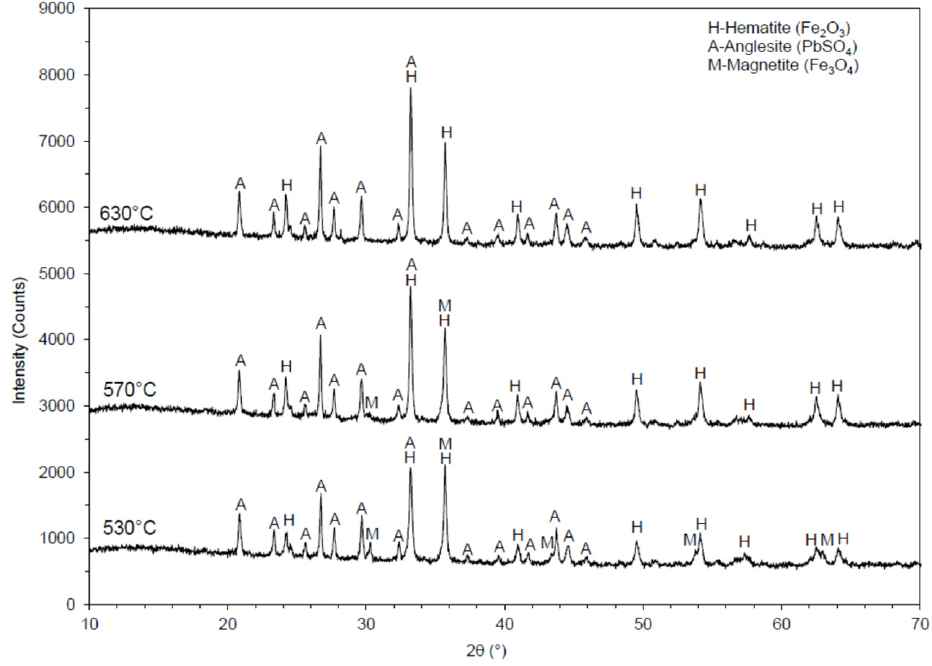
Figure 7. Diffractogram of calcined jarosite samples at 530, 570, and 630 ◦ C. Figure 7. Di ff ractogram of calcined jarosite samples at 530, 570, and 630 °C. A diffractogram obtained from XRD analysis of the jarosite sample roasted at 570 ◦ C is presented in Figure 6. In this sample, the following minerals were identified: hematite (Fe 2 O 3 ), anglesite (PbSO 4 ), and magnetite (Fe 3 O 4 ). Hematite was the most common mineral identified in the sample, anglesite was less evident, while magnetite was the least evident. By comparison, the magnetite peak intensities presented in the diffractograms of the samples at 530 and 570 ◦ C showed that the presence of magnetite in the jarosite sample roasted at 570 ◦ C was less than in the sample roasted at 530 ◦ C. A diffractogram obtained from XRD analysis of a sample roasted at 530 ◦ C is pre- sented in Figure 6. In this sample, hematite (Fe 2 O 3 ) and anglesite (PbSO 4 ) were identified. Hematite was the more common mineral in the sample, while anglesite was less evident. The XRD analysis showed that, at 630 ◦ C, iron was completely transformed into Fe 2 O 3 .